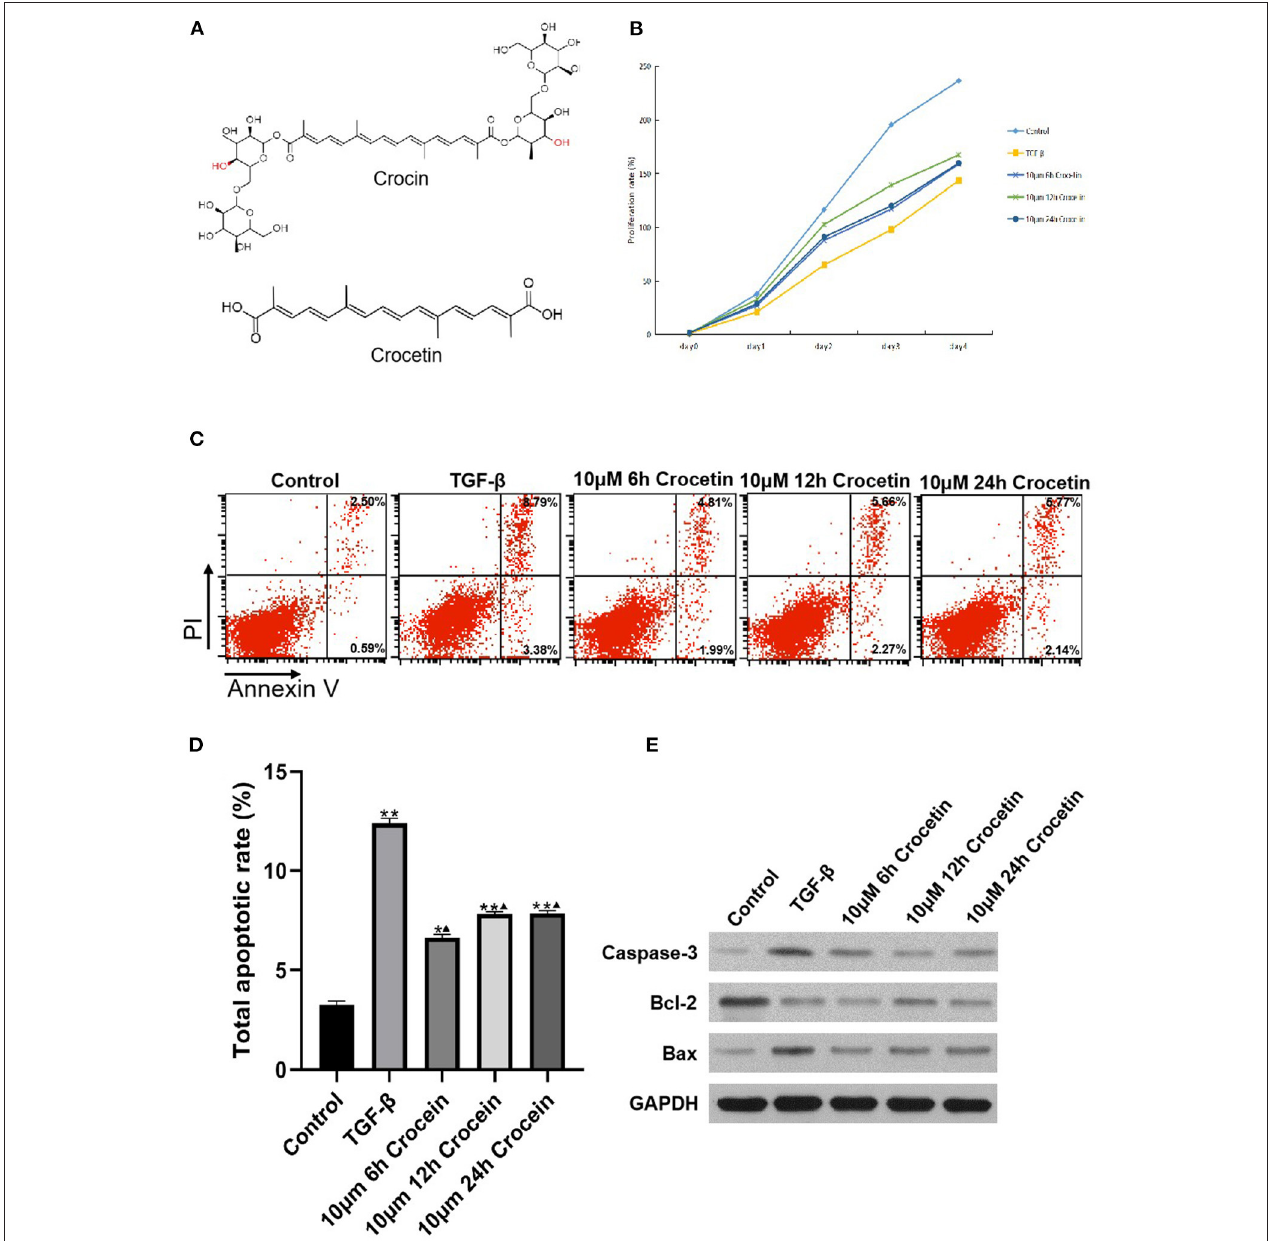
FIGURE 1 | LO2 cells were incubated with 10 µ M of crocetin for 6, 12, and 24h, respectively, and then induced by 2ng/ml of TGF- β . Cell viability was measured by CCK-8 and apoptosis was by flow cytometry. (A) Chemical structure of crocetin. (B) Cell viability was detected by CCK-8 assay. (C) Cell apoptosis was measured by flow cytometry. (D) Cell apoptosis was compared among the groups with or without crocetin pre-treatment and/or TGF- β induction. (E) Apoptosis proteins Caspase-3, Bcl-2, and Bax levels in LO2 cells were measured by Western Blotting. *Comparing to the Control, P < 0.05. **Comparing to the Control, P < 0.01. N Compared to TGF- β , P <